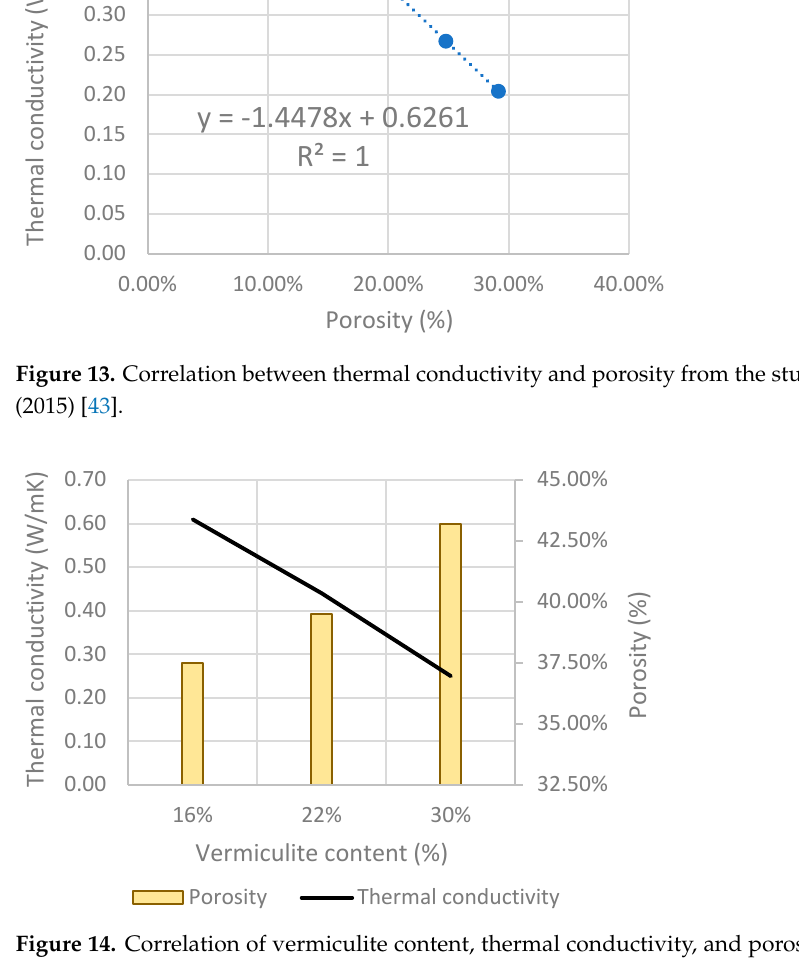
Figure 14. Correlation of vermiculite content, thermal conductivity, and porosity results from the study by Koksal et al. (2015) [48].